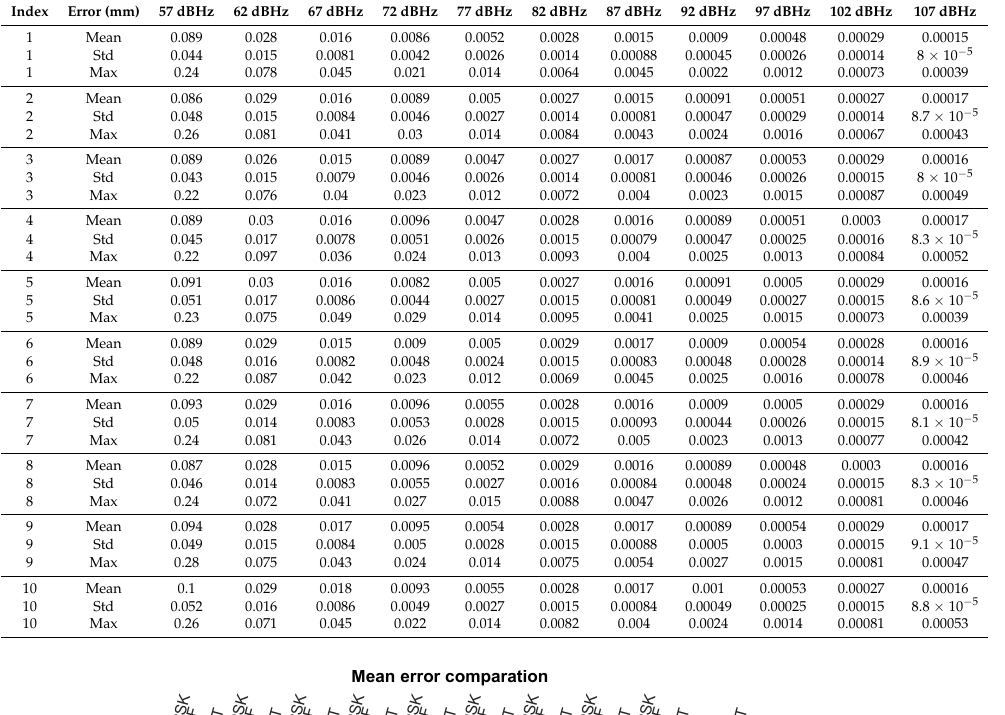
Table A7. Mean values, standard deviation, and maximum error values in the calculation of the impact point using FDMA-FFT with a 10-bit size.